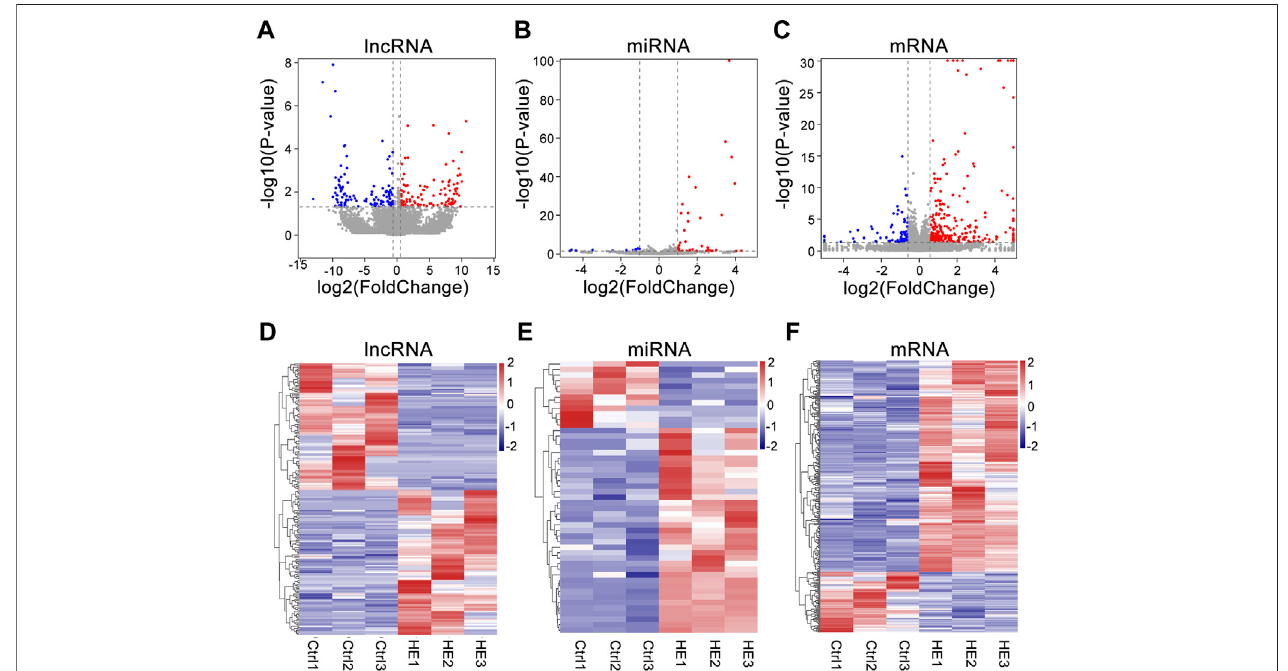
FIGURE 3 | Expression Pro fi les of lncRNAs, miRNAs, and mRNAs in HE hippocampus tissues compared to normal tissues. (A) Volcano plot of differentially expressed lncRNAs. (B) Volcano plot of differentially expressed miRNAs. (C) Volcano plot of differentially expressed mRNAs. The vertical and horizontal coordinates respectively represent − log10 scaled ( p -value) and log2-scaled fold changes. Horizontal dashed line indicates p -value < 0.05 and vertical dashed lines represent ≥ 2.0 × fold change. Red and blue dotsrepresentupregulationand downregulationRNAs, respectively. (D) Heat map ofdifferentially expressed lncRNAs. (E) Heat map of differentially expressed miRNAs. (F) Heat map of differentially expressed mRNAs. (Red color indicates upregulation; blue indicates